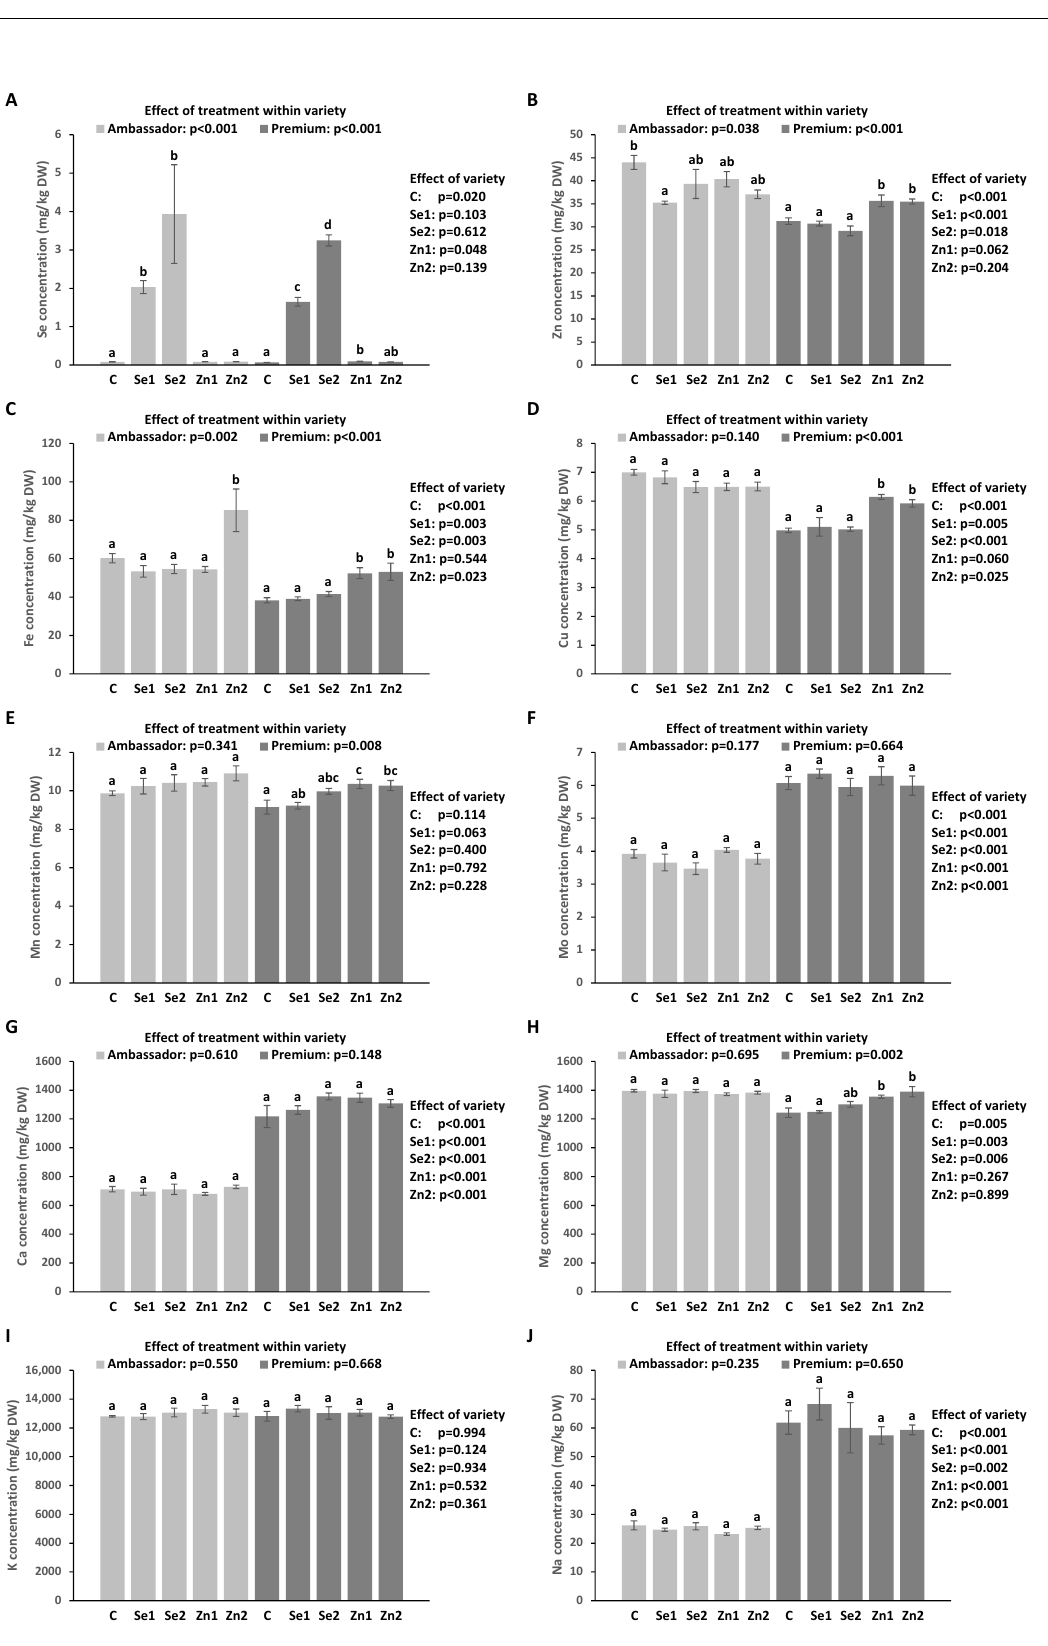
Figure 2. Foliar-applied Se and Zn and variety affect the concentration of Se ( A ), Zn ( B ), Fe ( C ), Cu ( D ), Mn ( E ), Mo ( F ), Ca ( G ), Mg ( H ), K ( I ), and Na ( J ) in seeds. C (control): without Se and Zn; Se1: 50 g; Se2: 100 g; Zn1: 375 g; Zn2: 750 g; all per ha; mean ± SD; n = 4. Bars that do not share an identical lower letter differ significantly within variety. p -values on the right part of the graph display the impact of treatment across varieties (Ambassador compared to